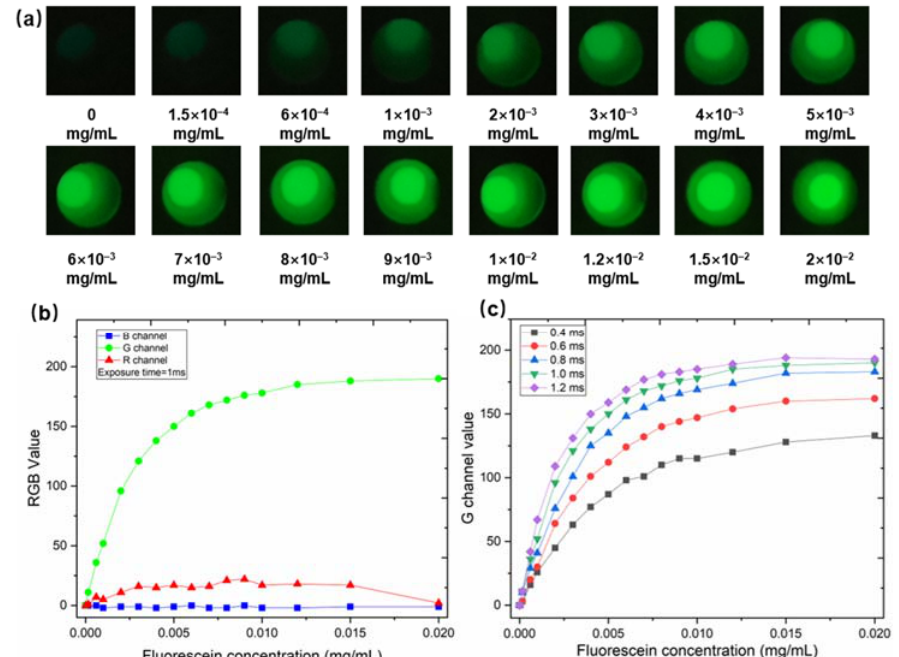
Figure 3. The result of fluorometric measurements using FITC as a standard model analyte. ( a ) The fluorescence images of the different concentrations of FITC solutions (between 0 and 2 × 10 − 2 mg/mL). ( b ) Fluorescence responses were obtained from red, green, and blue channels at the same excitation light intensity and exposure time. ( c ) Fluorescence responses of the green channel of fluorescein at the same excitation light intensity for different exposure times.